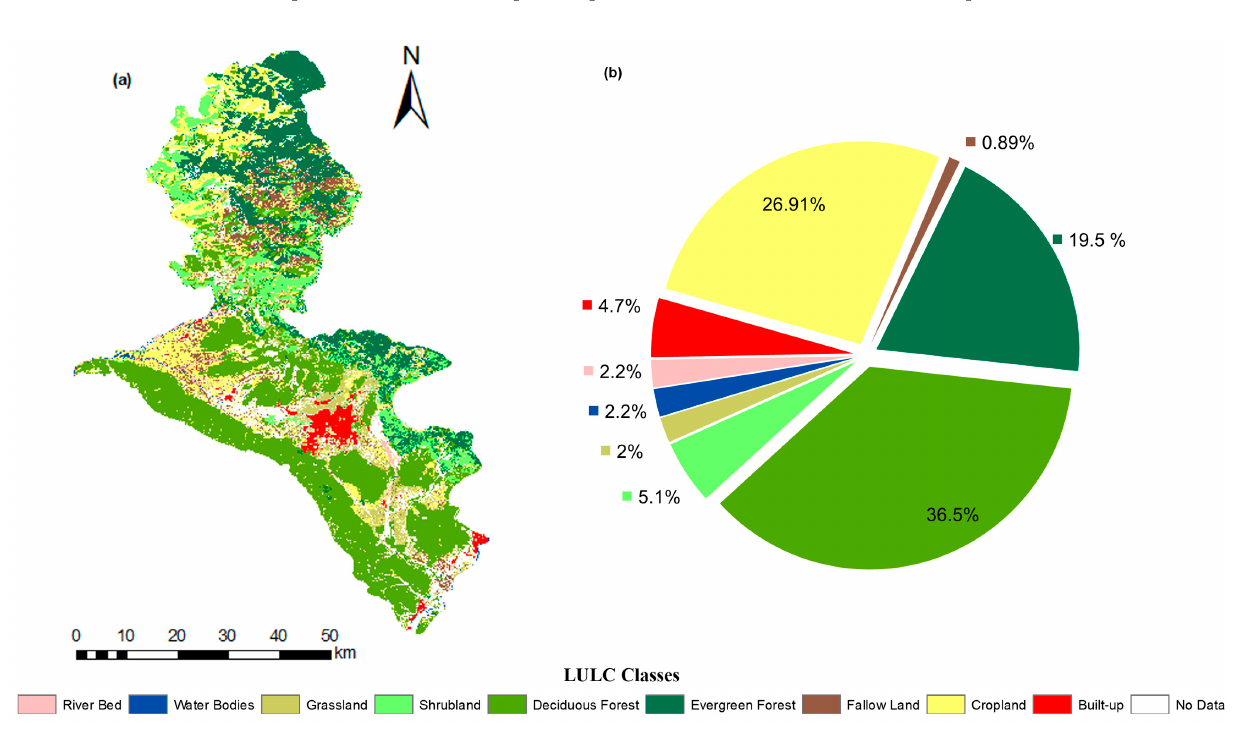
Figure 4. ( a ) Reference land cover map prepared in this study and ( b ) area-wise distribution of land cover classes (excluding the “no data”